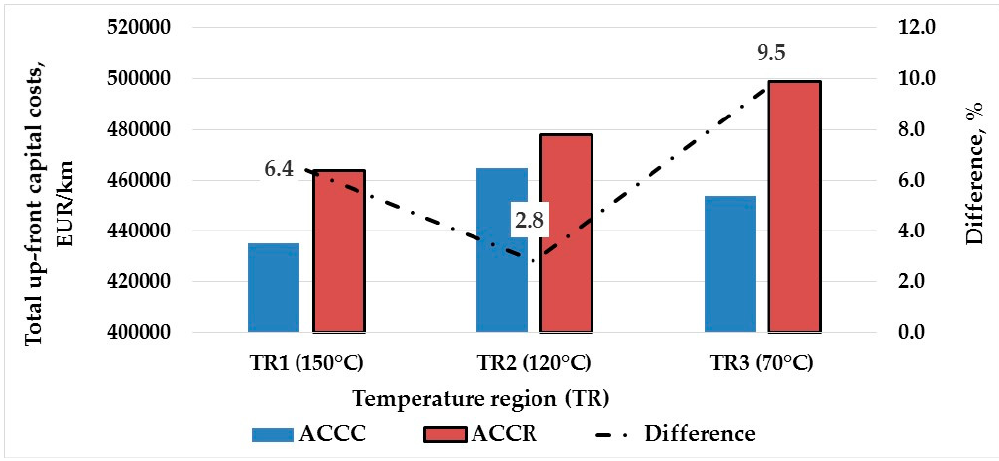
Figure 14. Total up-front capital costs for construction of a new TL for “OHL No.2” case.